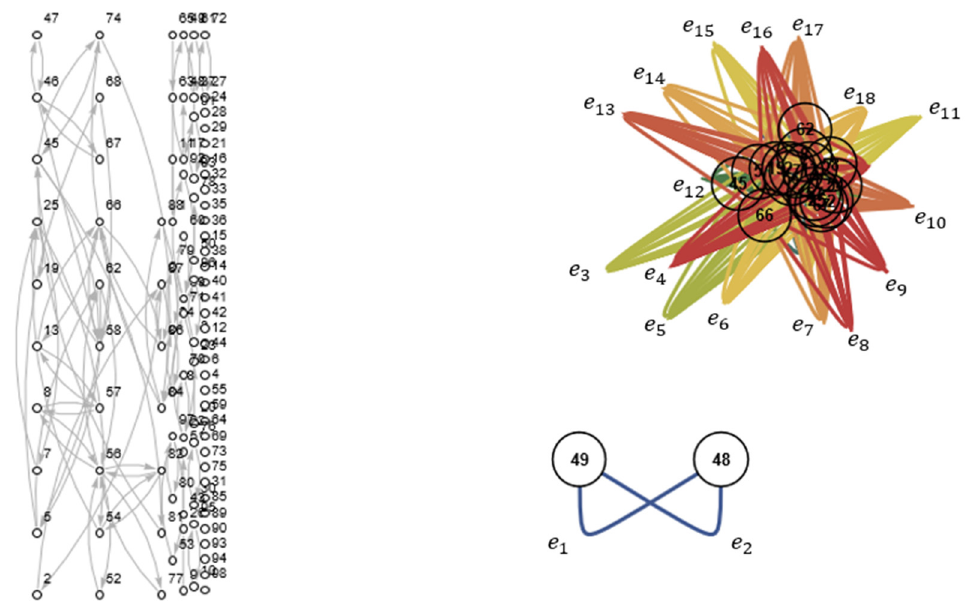
Figure 5. Directed network (on the left) and a network soft set (on the right) representation for the 2018 post-stress economic period. Note: Numbers denote company indices (see Tables A1 and A2) and E = { e 1 , e 2 , . . . , e 18 } is the soft parameter set.